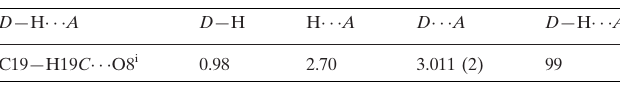
Hydrogen-bond geometry (A˚ , (cid:3)